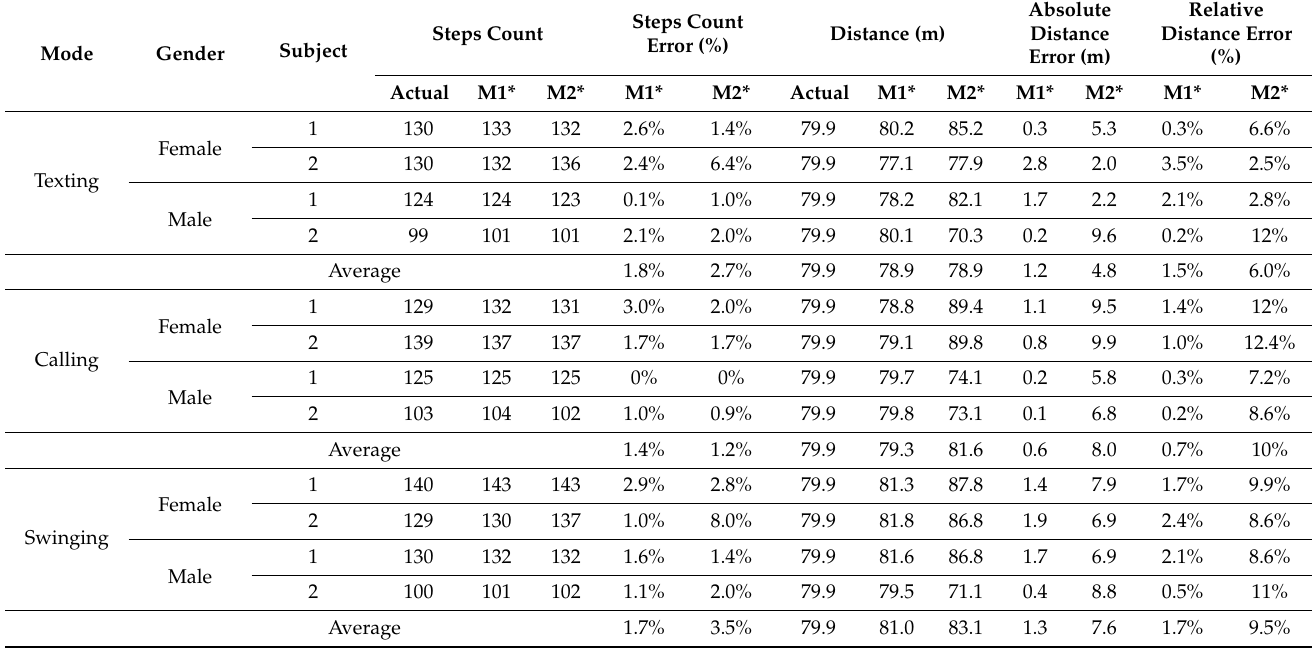
Table 8. Distance estimation of the rectangular path.